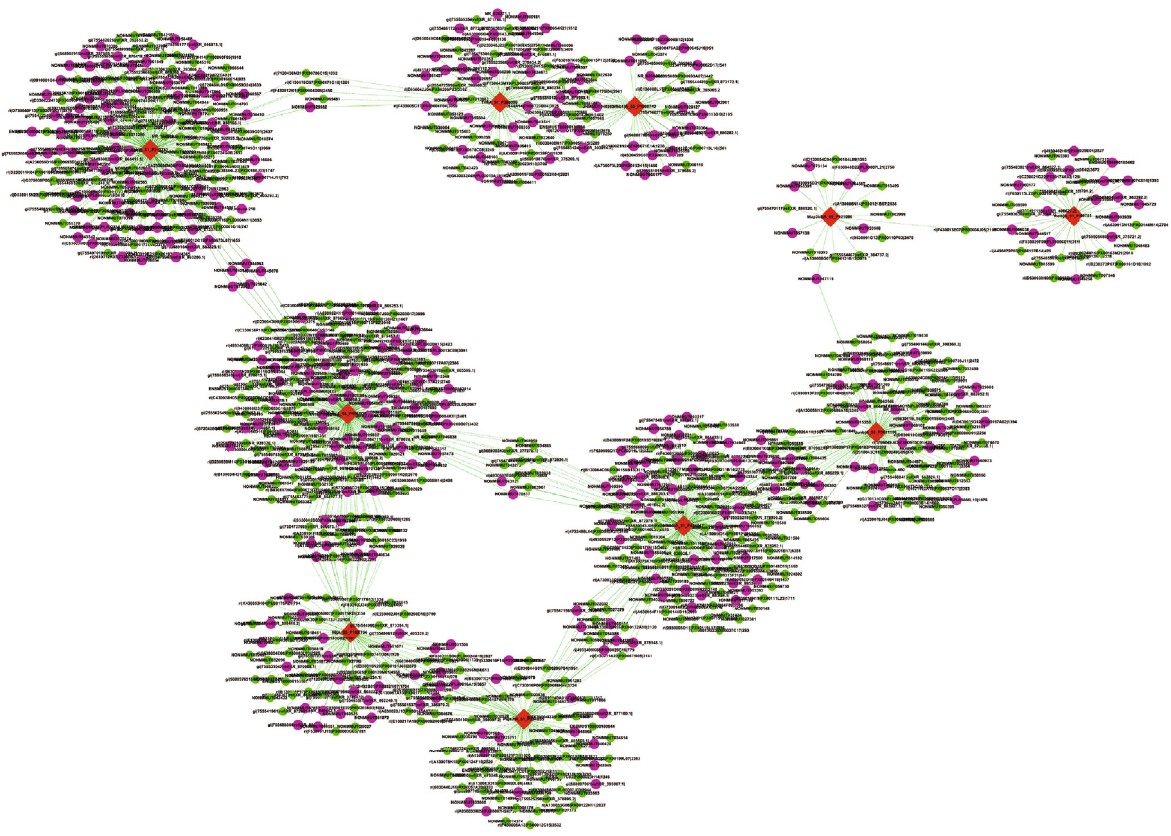
Figure 5: Coexpression network of ten signi fi cantly upregulated mRNAs with their associated lncRNAs. The network was based on Pearson ’ s correlation coe ffi cient (the absolute value of PCC ≥ 0 : 90 , p value < 0.01, and FDR < 0 : 01 ), and solid lines mean positive correlations while dashed lines mean negative correlations. Diamond nodes represent mRNAs, and purple circle nodes represent lncRNAs. Red color and pink color represent upregulation; green color represents